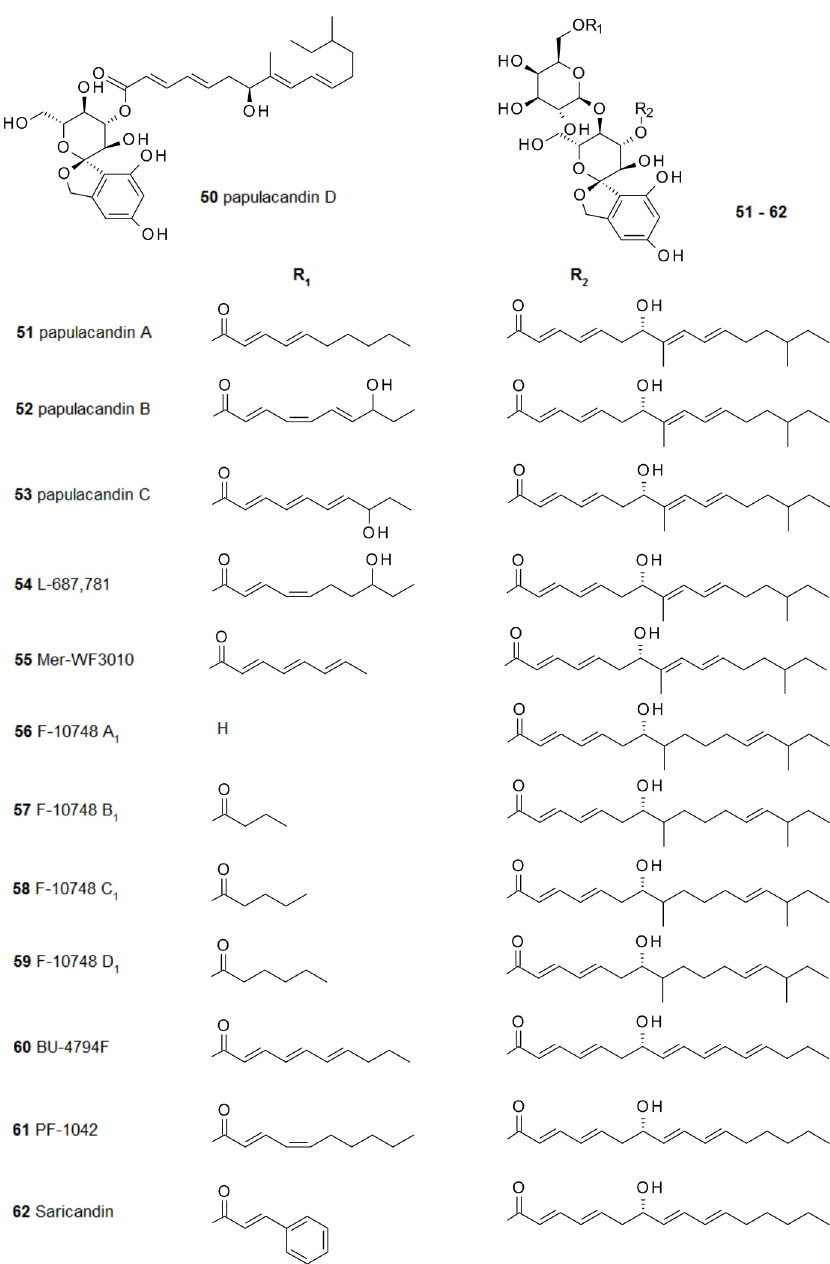
Figure 6. Papulacandins and related antifungal compounds possessing a spiroketal moiety.